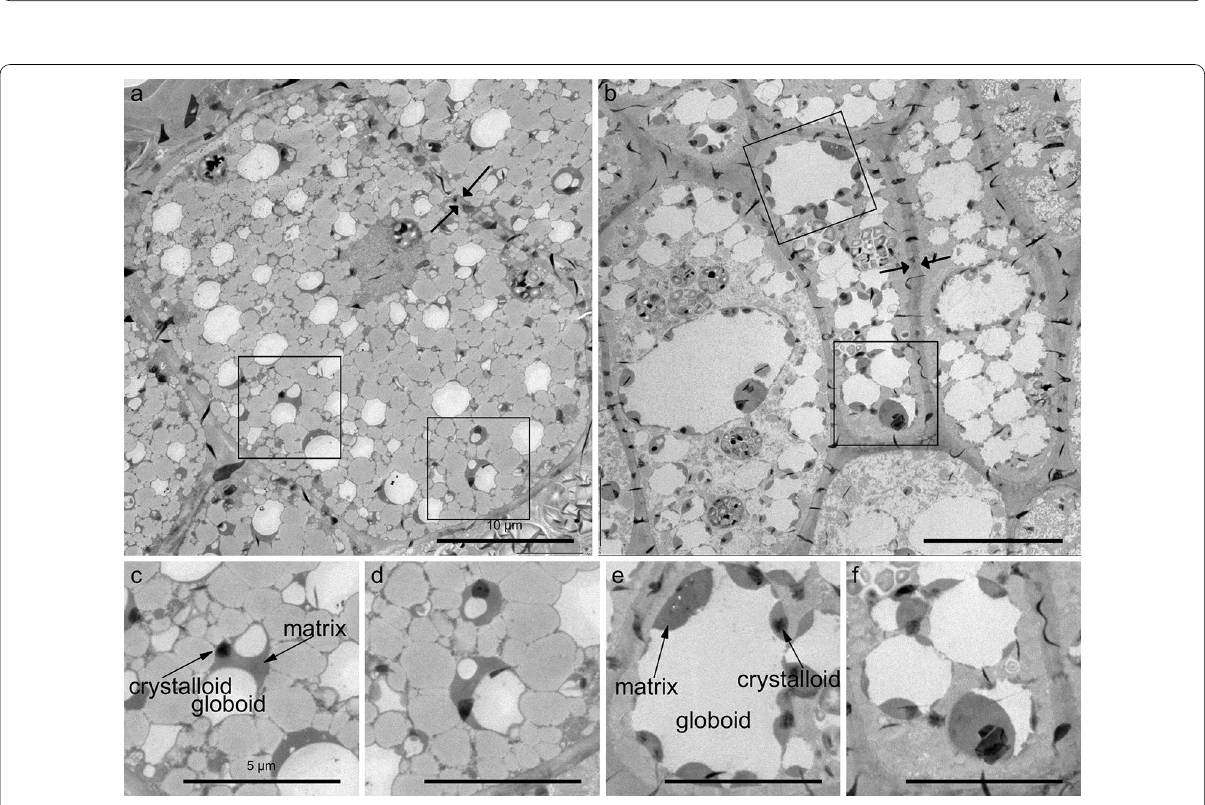
Fig. 4 Transmission electron microscopy (TEM) showing the aleurone cell structure of the transverse section of the rice caryopsis. a wild‑type; b ta2-1 . The thick cell wall is shown between the arrows and aleurone grains (AG) are selected with black square. c – f magnified images selected as AG; c and d wild‑type AG; e and f ta2-1 AG. Scale bar for a and b